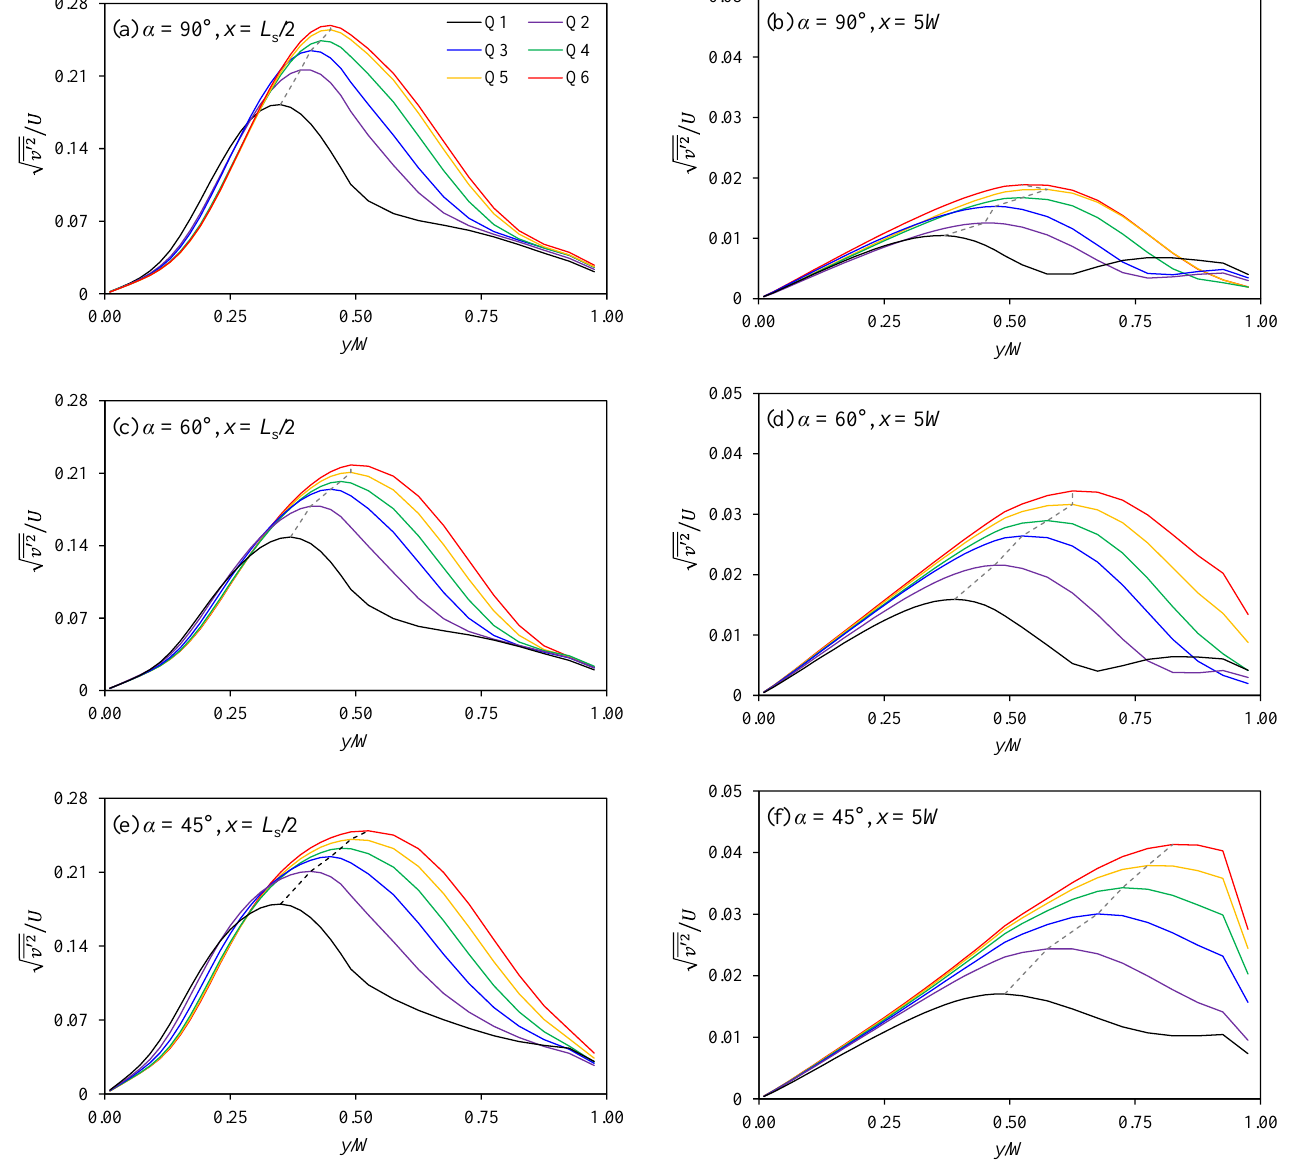
and x = 5 W (dashed line: the trajectory of the maximum transverse velocity shear).